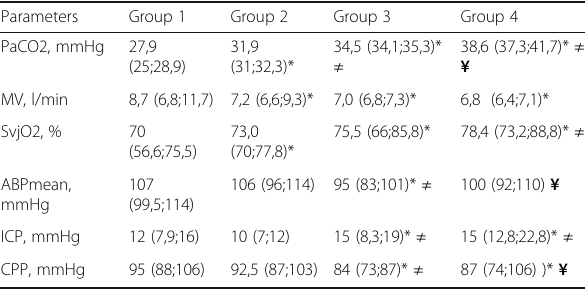
Table 1 (abstract 001454). Dynamics of intracranial pressure, mean arterial blood pressure, cerebral perfusion pressure and cerebral